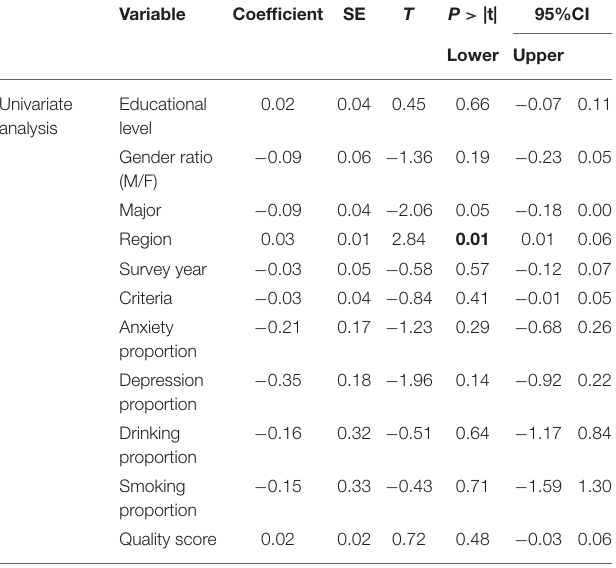
TABLE 3 | Univariate meta-regression analyses of prevalence of IBS.